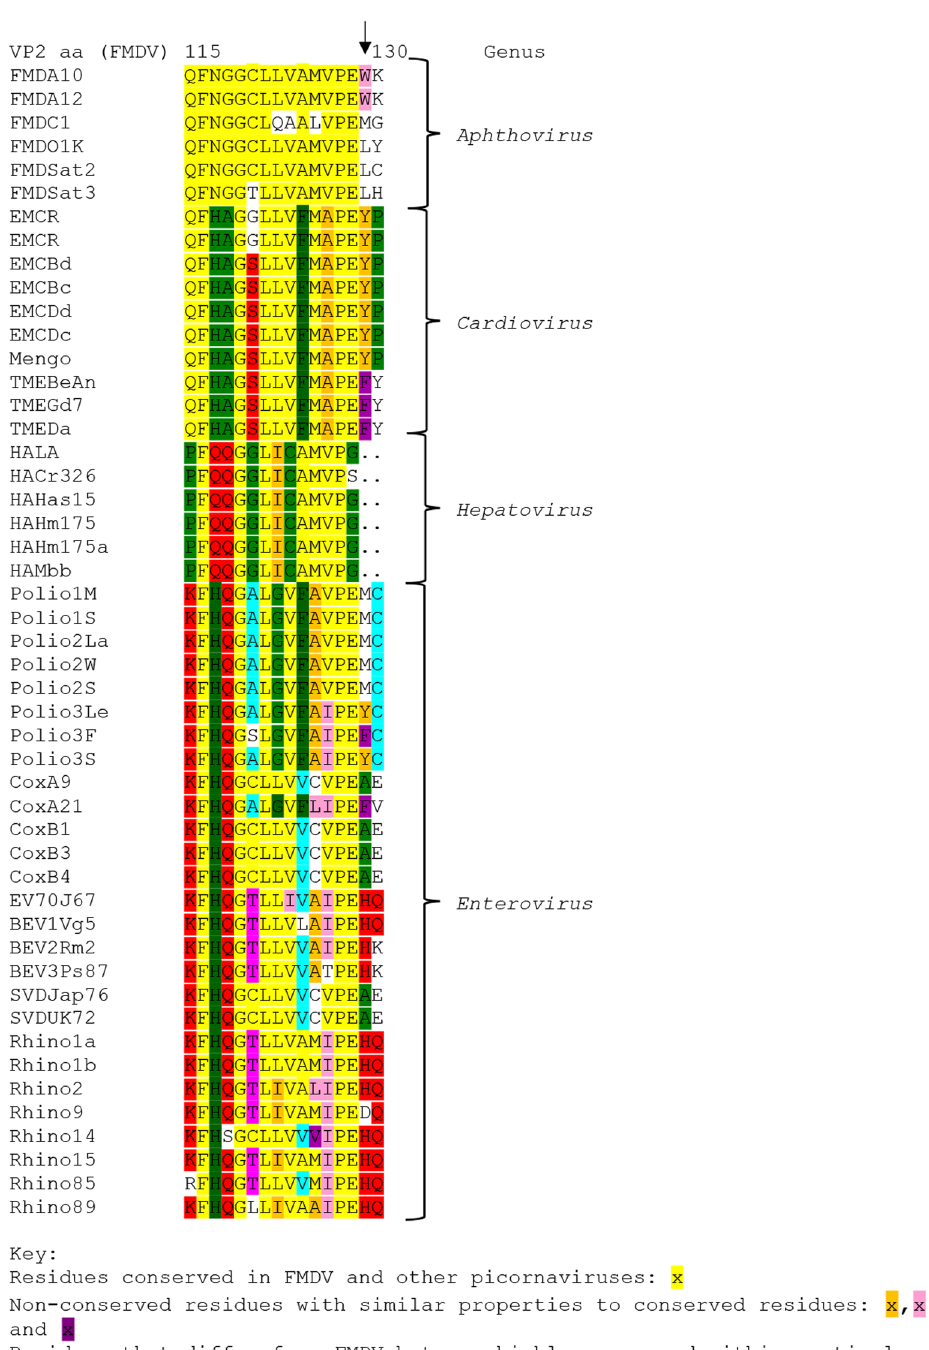
Figure 5. Conservation of VP2 sequences among picornaviruses. The amino acid sequence upstream of residue W129 within VP2 of FMDV (marked with an ↓ ) is highly conserved among other FMDVs and also among other picornaviruses. Amino acids that are identical among most FMDVs and are also conserved in other virus genera are highlighted in yellow. Non-conserved residues that have similar properties to the conserved residues are highlighted in other colours (see key). Residues that differ from FMDV but are highly conserved within particular virus genera or species are also marked. The selected viruses were derived from alignments available at